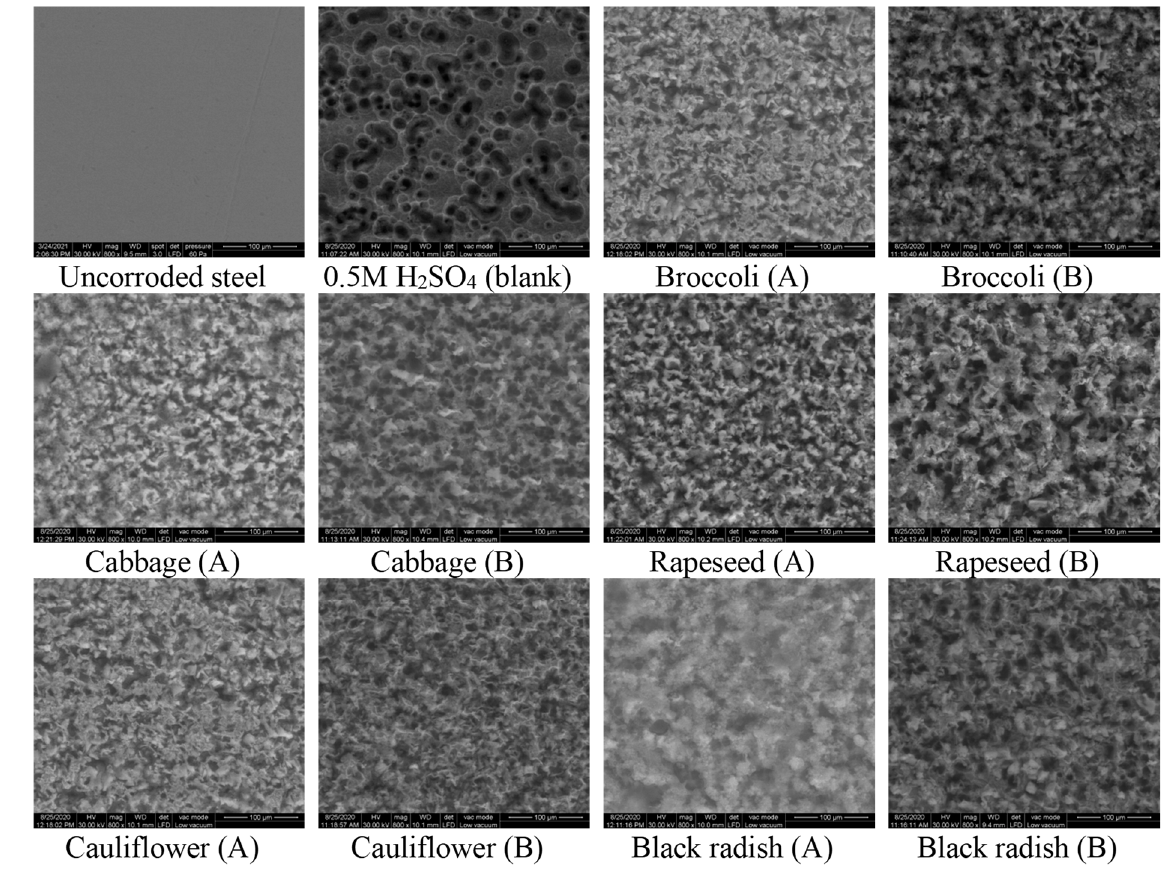
Figure 4. SEM images (800×) for steel, exposed to 0.5M H 2 SO 4 with and without Brassicaceae inhibi- tors, after electrochemical tests.